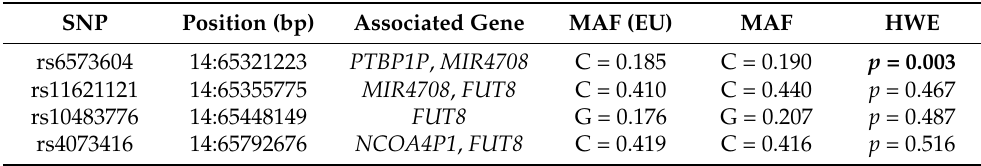
Table 1. Description of the enrolled rs6573604, rs11621121, rs10483776, and rs4073416 polymorphisms located in the FUT8 gene-related